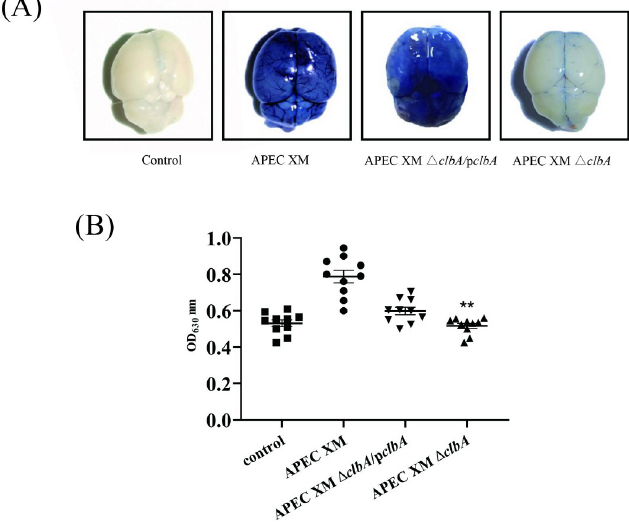
Fig 2. Determination of BBB integrity by EB staining. 10 mice in each group were inoculated intraperitoneally with 10 7 CFU of test bacteria (APEC XM, APEC XM Δ clbA , and APEC XM Δ clbA /p clbA )or with an equal volume of sterile saline. After 12 h of infection, 2% EB solution was injected to the mice. EB content that penetrated the brain was determined by measuring the absorbance (OD 630 ) after brain homogenization and precipitation. (A) Dorsal view of Evans blue stained mouse brains after EB injection; (B) Quantification of EB content in mice brain. Dots represent the OD 630 values of EB content in the brains of each infected mouse. Data were analyzed with SPSS 17.0 software using one-way ANOVA. Error bars represent the standard errors of the means. Significant differences between the wild-type strain APEC XM and the APEC XM Δ clbA are indicated ( �� p < 0.01, versus APEC XM